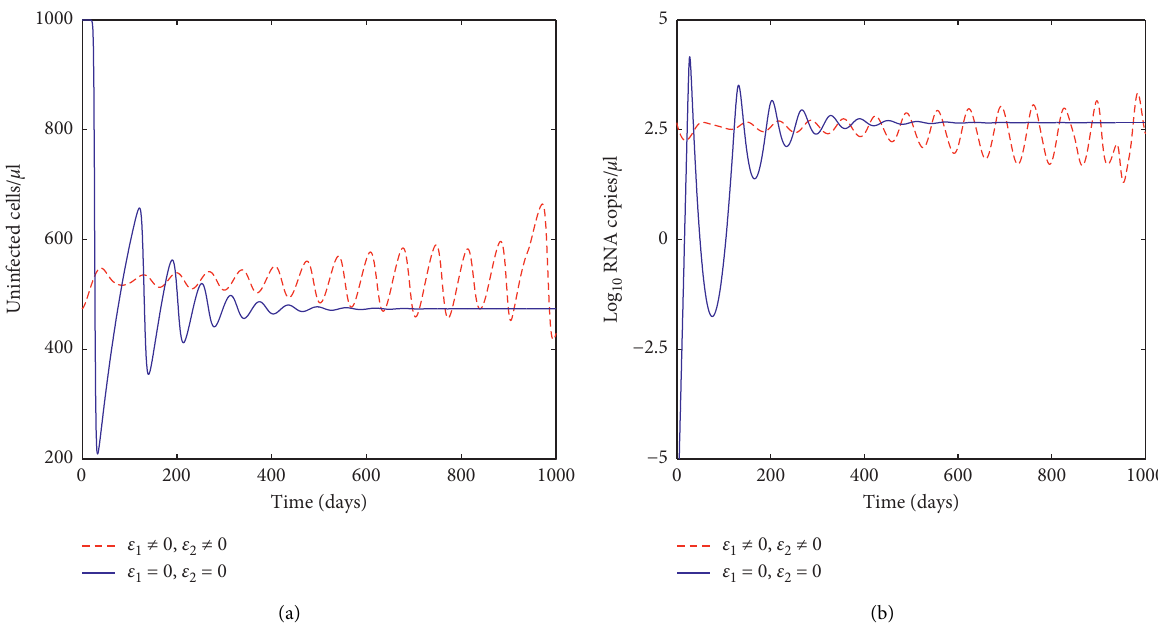
Figure 11: The level of (a) uninfected cells and (b) viral load corresponding to the optimal control strategy with ε are without control and dashed lines are with control, in which r